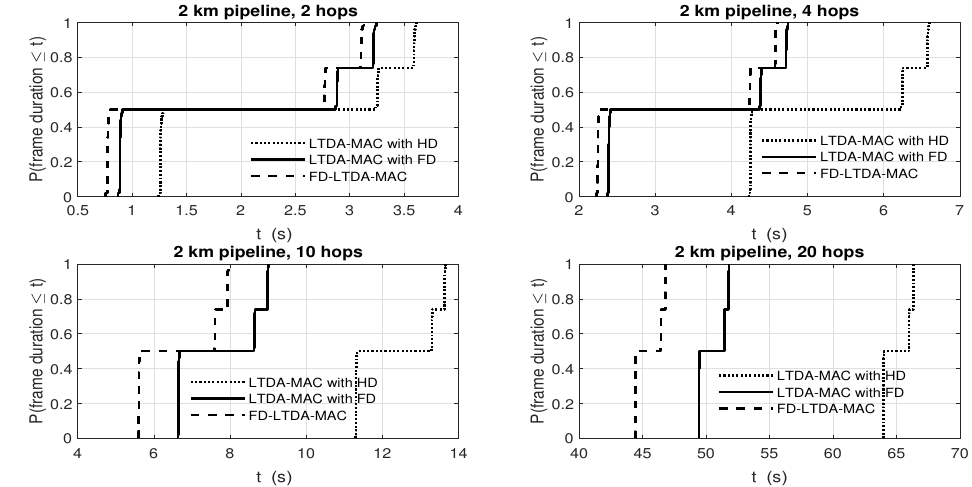
Figure 9. Frame duration cdfs of LTDA-MAC with HD nodes, LTDA-MAC with FD nodes, and FD-LTDA-MAC for a 2 km